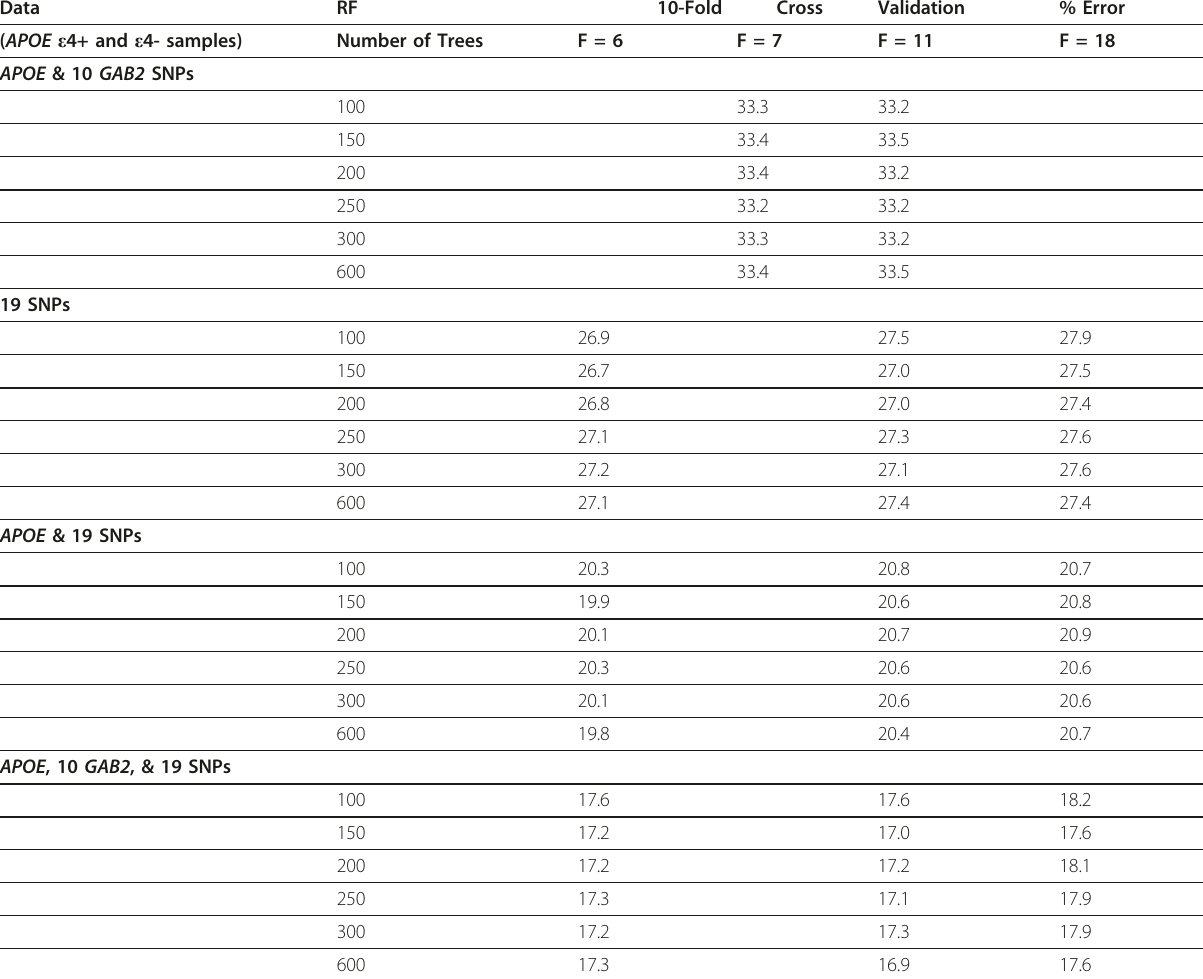
Table 4 RF modeling, filtered data, approach II.